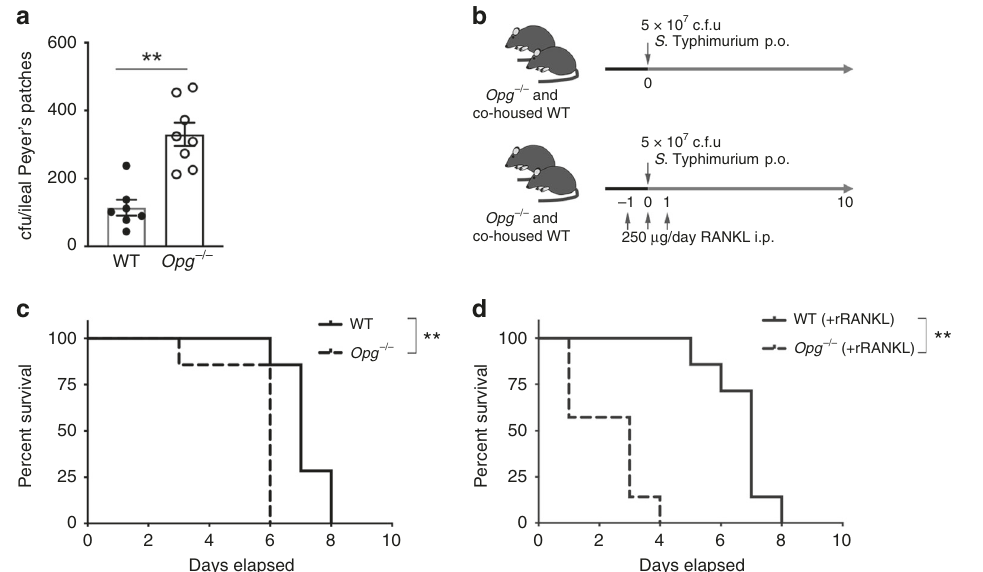
Fig. 9 OPG-de fi cient mice have increased susceptibility to S . Typhimurium infection. a Opg − / − or co-housed WT mice were orally infected with 5 × 10 8 c.f.u. of S . Typhimurium ( Δ aroA ). Ileal Peyer ’ s patches were collected 3 h after infection, and the numbers of colonies of S . Typhimurium ( Δ aroA )